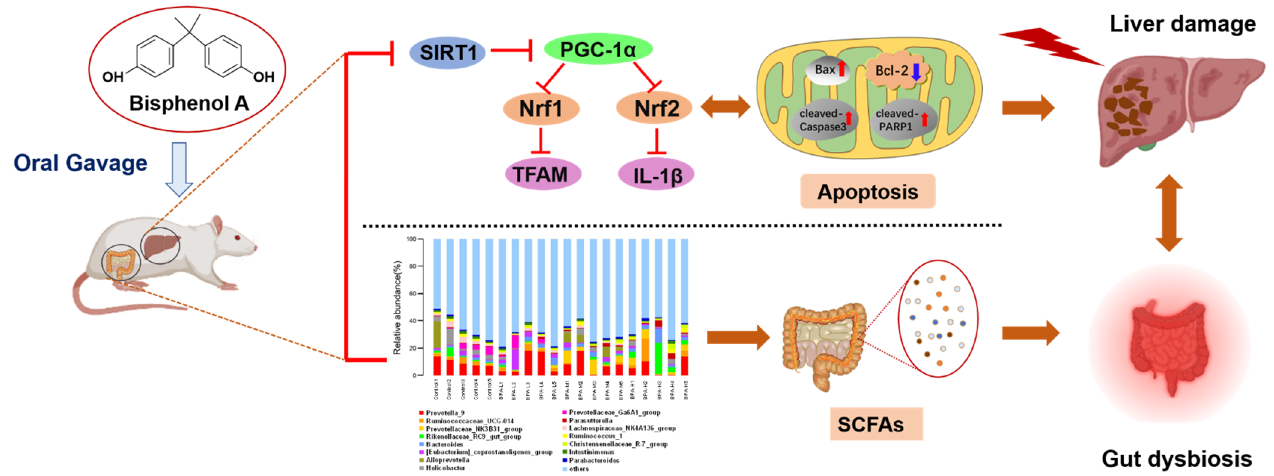
Figure 8. Schematic diagram of the mechanism of BPA-induced liver injury and gut microbiota dysbiosis in rat.